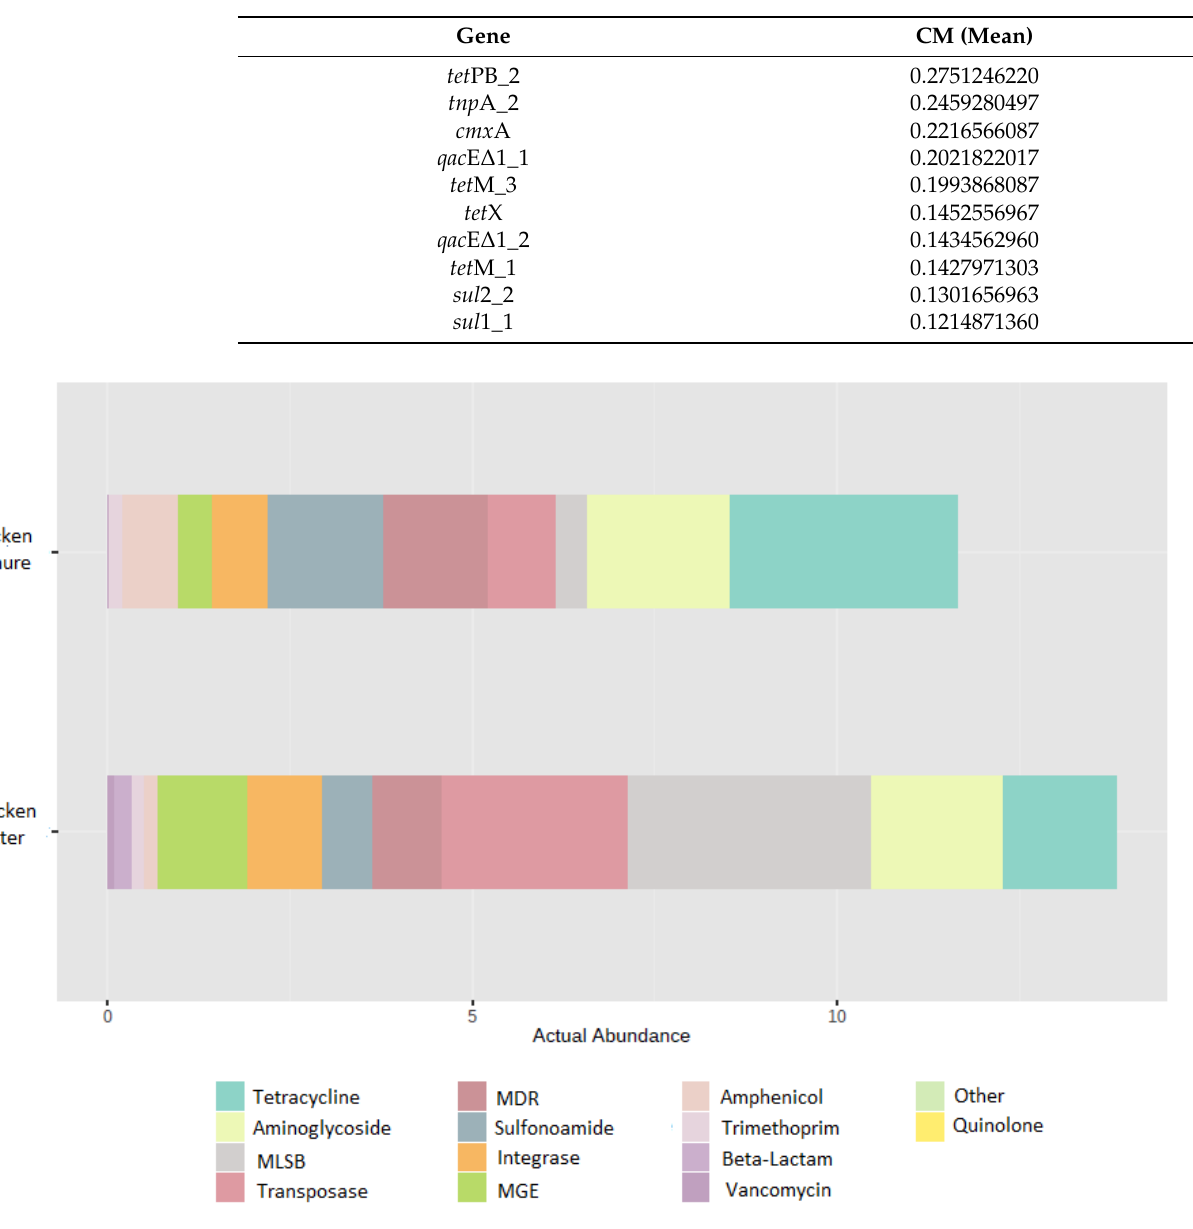
Table 6. The most prevalent ARGs found in CM; relative gene abundance calculated per 16S rRNA gene copies.